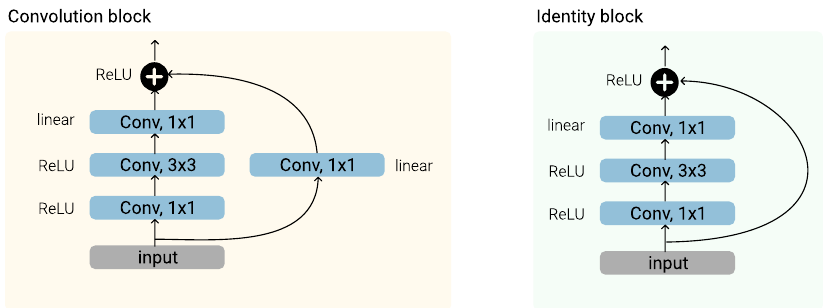
Figure 6. Two types of residual modules. Modules calculate f R ( x ) + g ( x ) (element-wise) where x denotes the module’s input, f R ( x ) the output of three stacked convolutional layers, and g the projection function used to match x and f R ( x ) dimensions in the convolution block, and the identity function g ( x ) = x in the identity block.